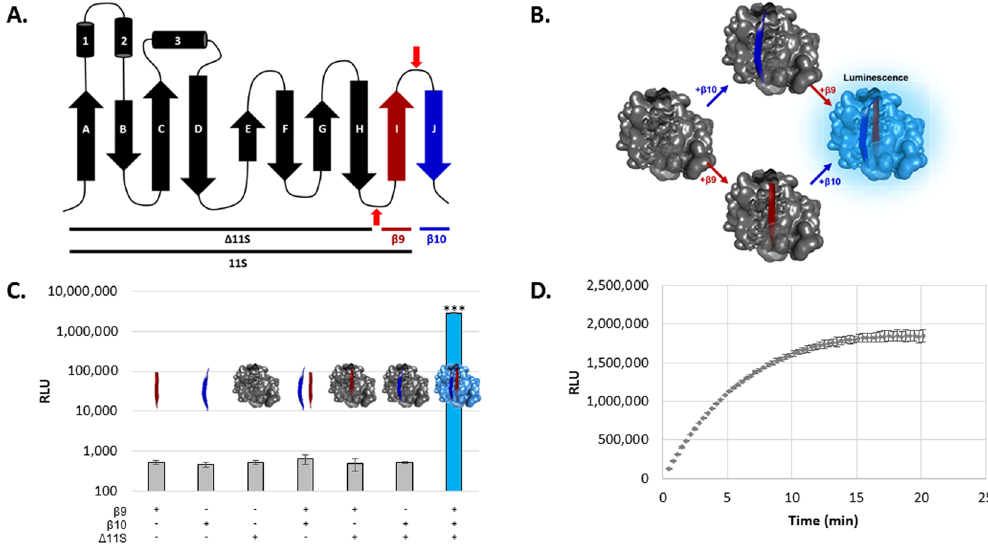
Figure 2. Design of a dual peptide complementation system. ( A ) Topological representation of the 10 β -stranded structure of NanoLuc (adapted from Dixon et al . 16 with permission from ACS Chem. Bio.). The ternary system consists of strands 1–8 ( Δ 11S) and two 11 amino acid peptides stemming from strands 9 ( β 9, red) and 10 ( β 10, blue). Sequences of Δ 11S, β 9, and β 10 are listed in supplemental information, Table S1. ( B ) Structural model illustrating the activation of Δ 11S only in the presence of both β 9 and β 10. Model was created from PDB ID 5IBO. ( C ) Luminescence produced from different combinations of the complementation components. Luminescence is only produced with all three components, *** p < 0.001. Concentrations of β 9, β 10, and Δ 11S were 1 μ M, 1 μ M and 1:10 5 dilution of lysate, respectively. ( D ) The luminescent signal over time following the addition of Δ 11S (1:10 5 dilution of lysate) to a solution of 1 μ M β 9 and β 10. Under these conditions, full complementation occurs in under 20 minutes.